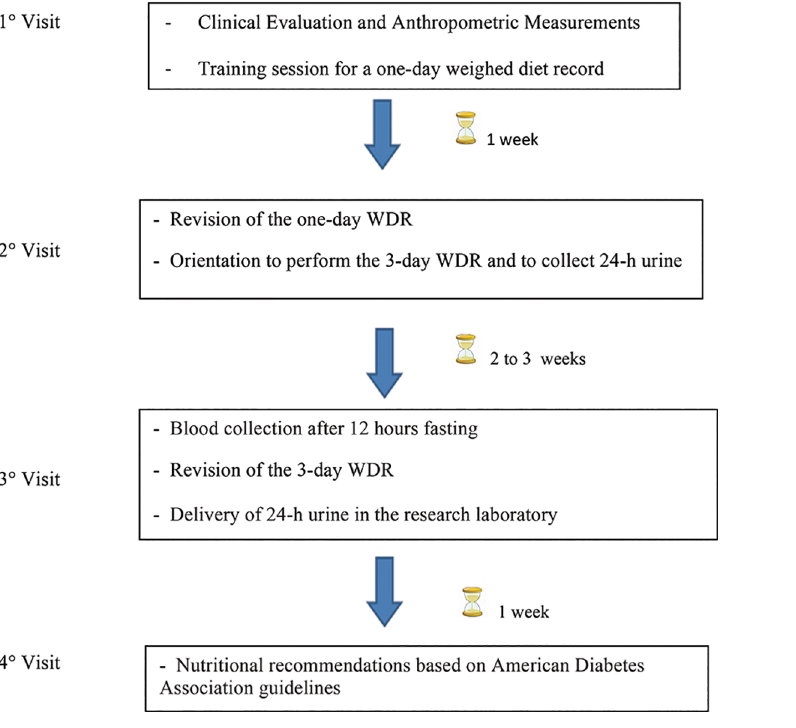
Fig 1. Diagram of the study